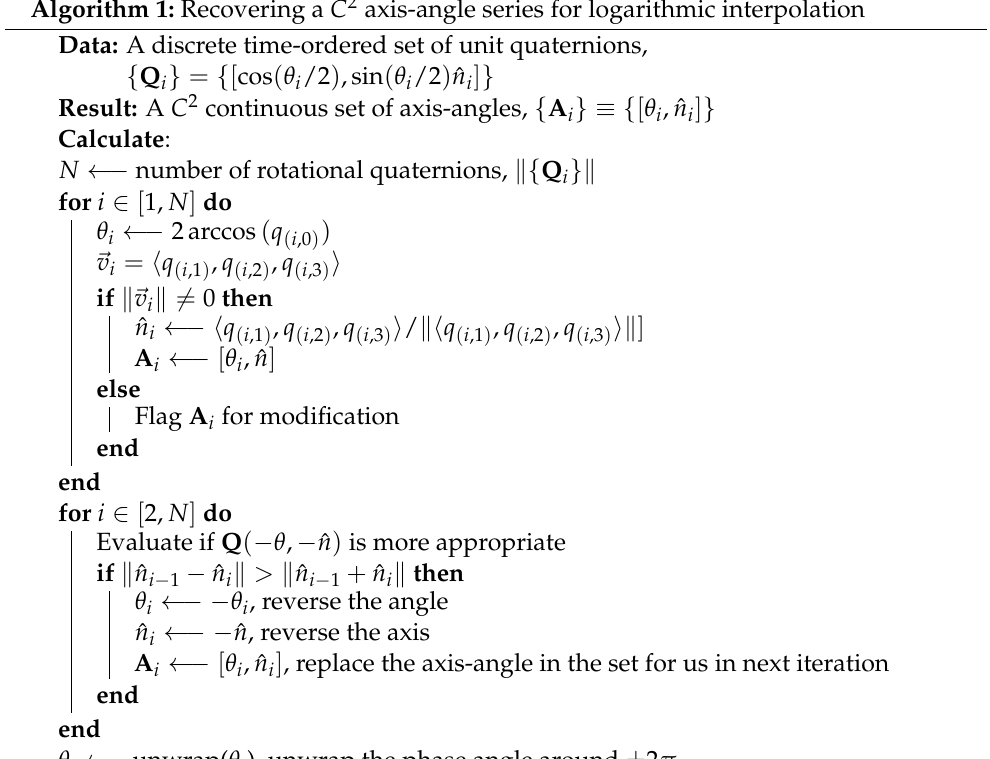
Algorithm 1: Recovering a C 2 axis-angle series for logarithmic interpolation Data: A discrete time-ordered set of unit